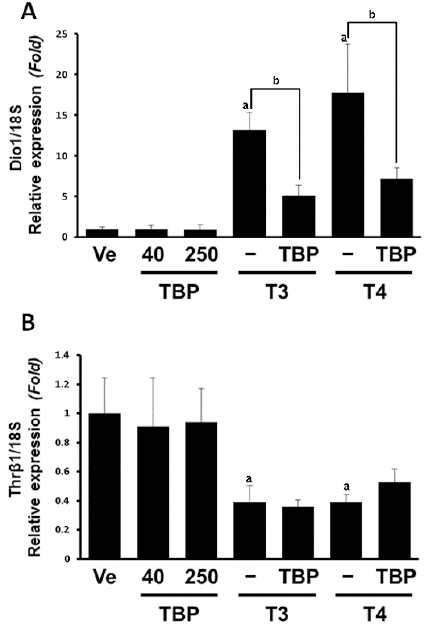
Figure 2. Expression levels of Dio1 ( A ) and Thr β 1 ( B ) mRNA in liver. Results presented in the bar